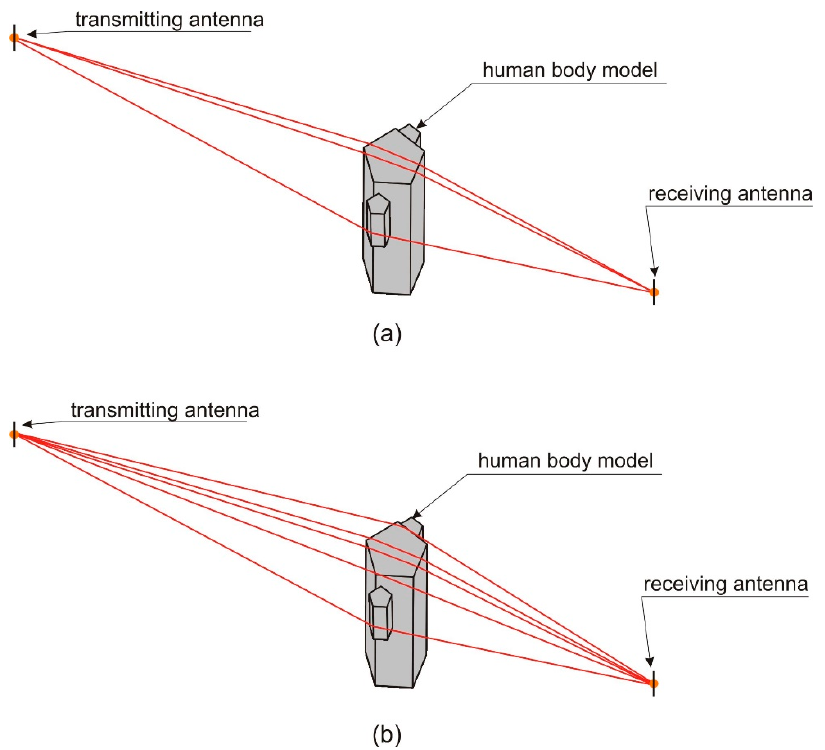
Figure 7. Ray-paths for human body models with five sidewalls: ( a ) For the receiver located at the distance, b = 1 m; ( b ) For the receiver located at the distance, b = 1.1 m.